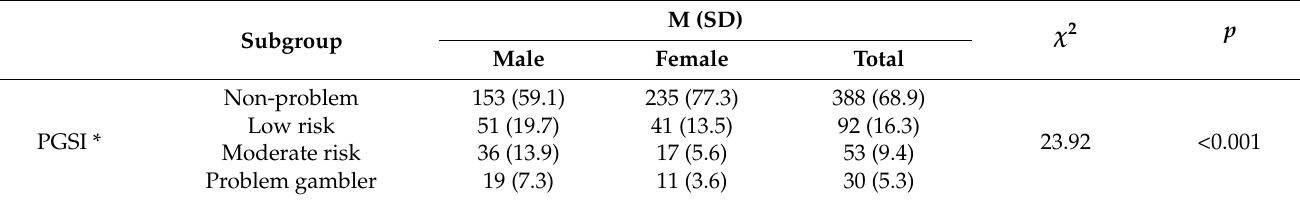
Table 2. A comparison of PGSI on by gender ( n male = 259, n female = 304).